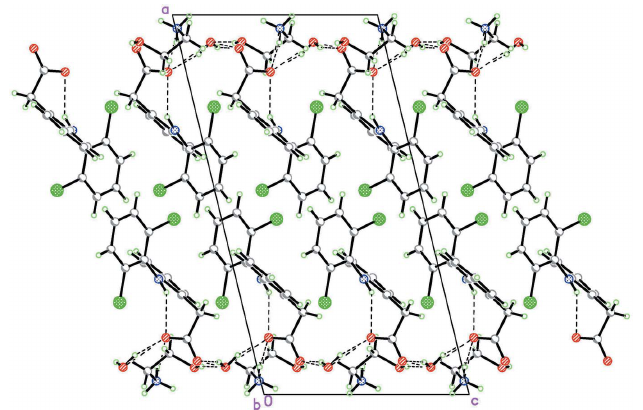
Figure 2 Packing diagram of the title compound, viewed down b axis. The hydrogen bonds are shown as dashed lines.